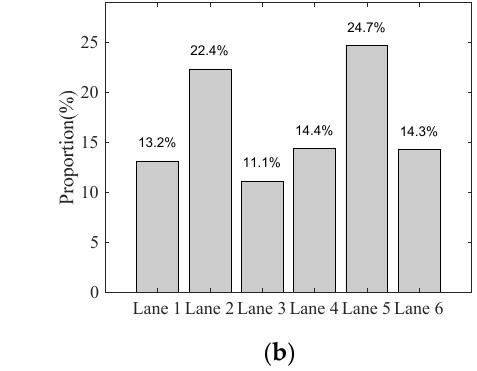
Figure 3. Statistical proportions of traffic flow in the investigated bridge. ( a ) Proportion of different vehicle types. ( b ) Proportion of traffic flow for each lane. The frequency histograms of the gross weight of each vehicle type and the corre- sponding estimated probability density functions (PDFs) are shown in Figure 4. The fol- lowing analysis ignores the F-type vehicles due to their lightest weights.